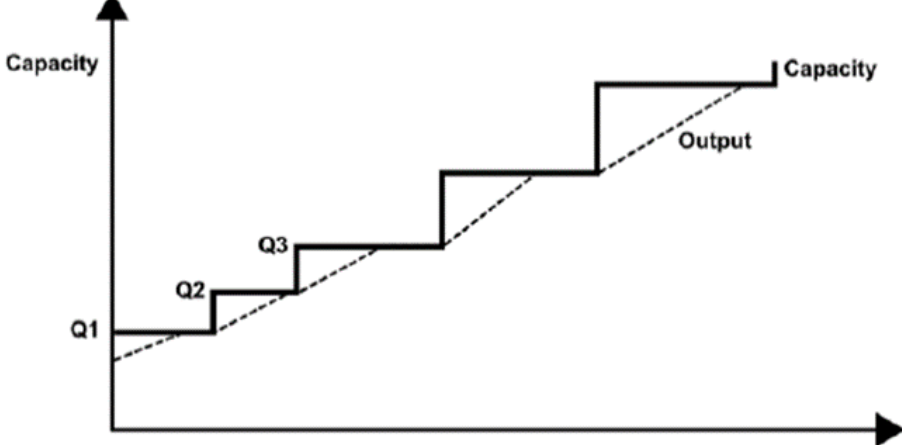
Figure 8. Indication of lumpy investment on SMC-based